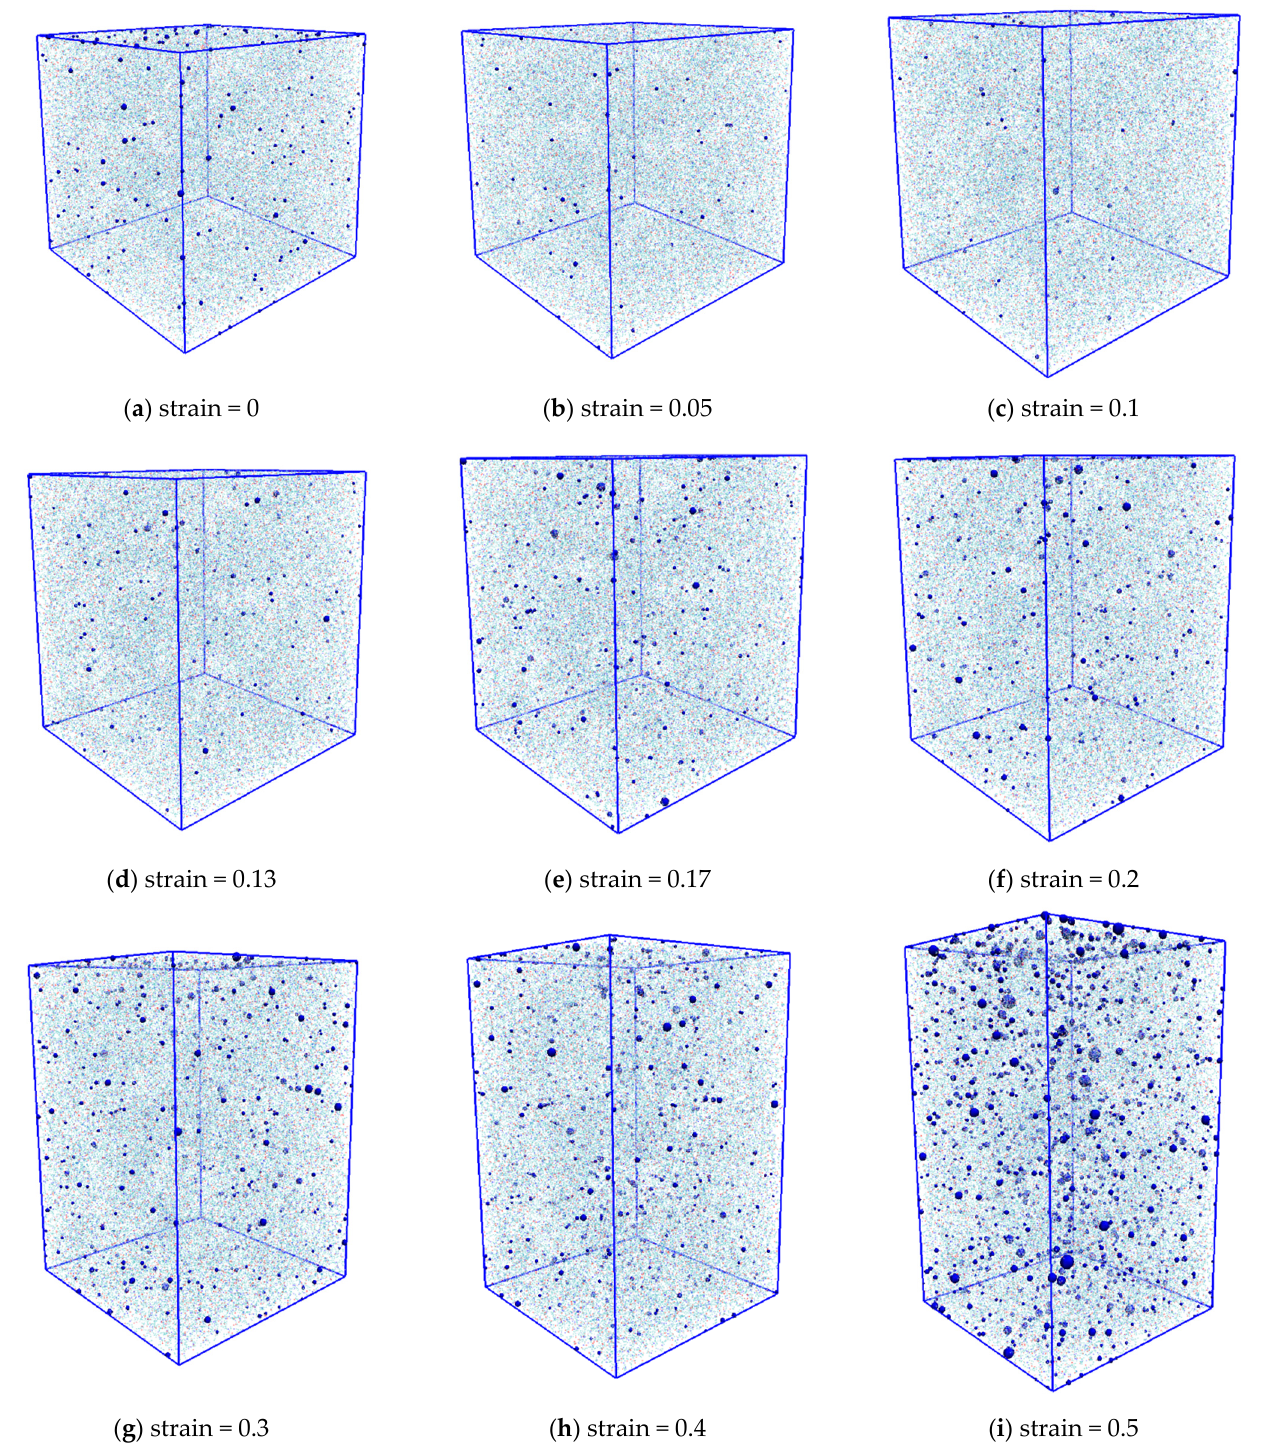
Figure 3. The generation and growth of voids inside the resin at each strain. The blue dots indicate voids, and the number and size of voids increase with increas- ing strain. This indicates that damage was generated by the simulation. Furthermore, en- tropy increases with increasing void volume, as shown in Figure 4.